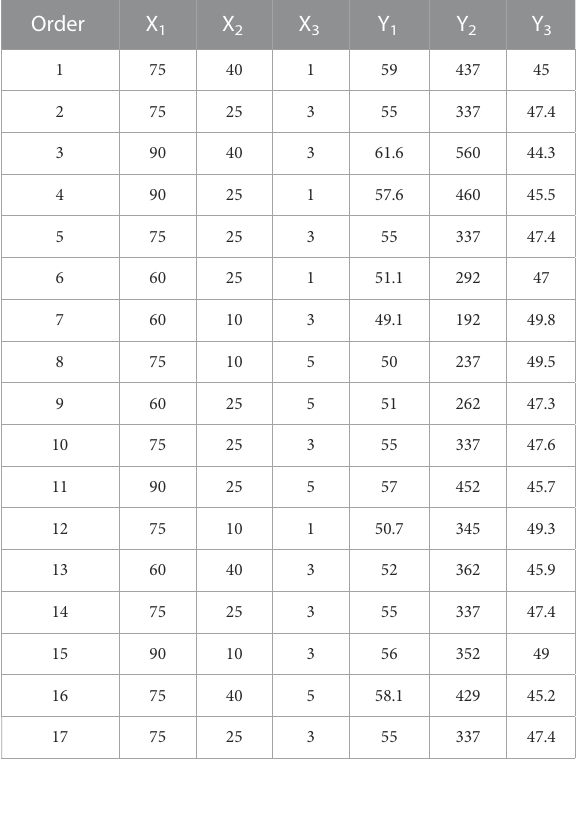
TABLE 8 Surface energy parameters of three test liquids. Liquid